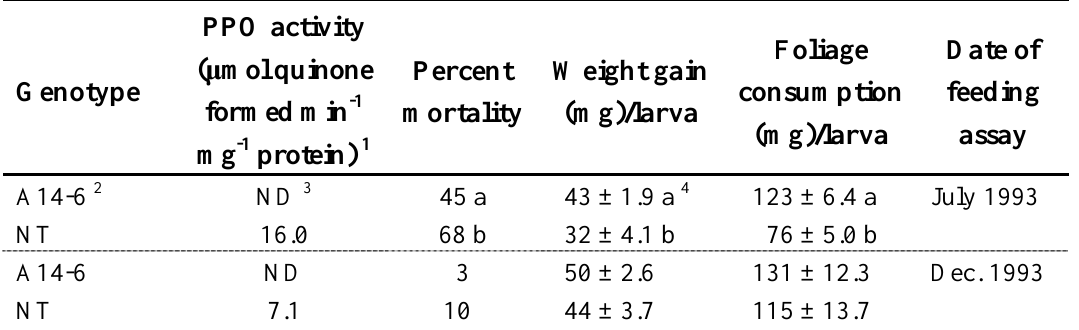
Table 2. Percent mortality, weight gain and foliage consumption of Colorado potato beetle feeding on transgenic tomatoes with suppressed PPO activity and nontransformed